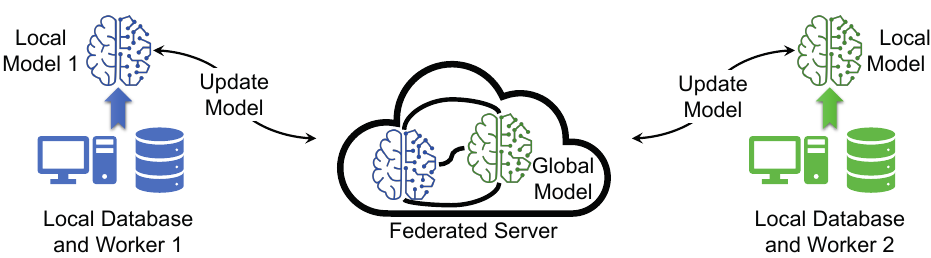
Figure 15. A Distributed Training of a Global Knowledge Model via Federated